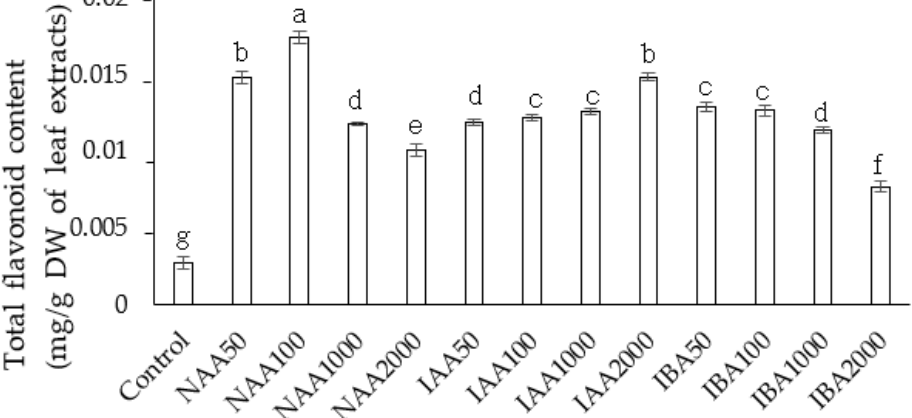
Figure 8. The effect of auxin concentration on total flavonoid content in C. indicum. Values are reported as mean ± standard deviation of three parallel experiments. Different letters indicate statistical differences as assessed by Duncan’s multiple comparison tests ( p <